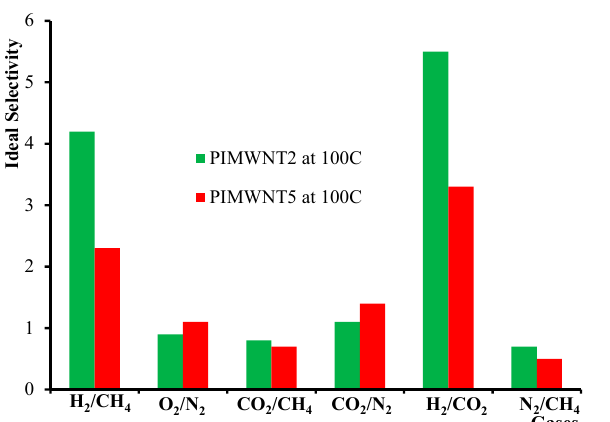
Figure 11. Ideal selectivities for PI, PIMWNT2, and PIMWNT5 membranes at 25, 50, and 100 °C corresponded to H 2 / CH 4 , O 2 / N 2 , CO 2 / CH 4 , CO 2 / N 2 , H 2 / CO 2 , and N 2 / CH 4 pair of gases.